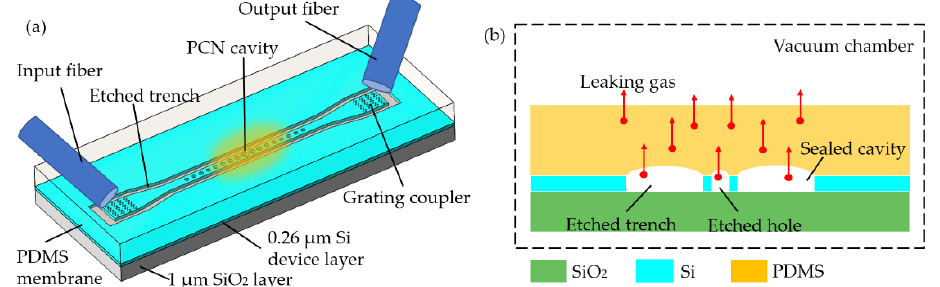
Figure 9. ( a ) Schematic of PCN cavity with polydimethylsiloxane (PDMS) coating; ( b ) cross-sectional view of gas cell and membrane deformation caused by pressure difference [101] .